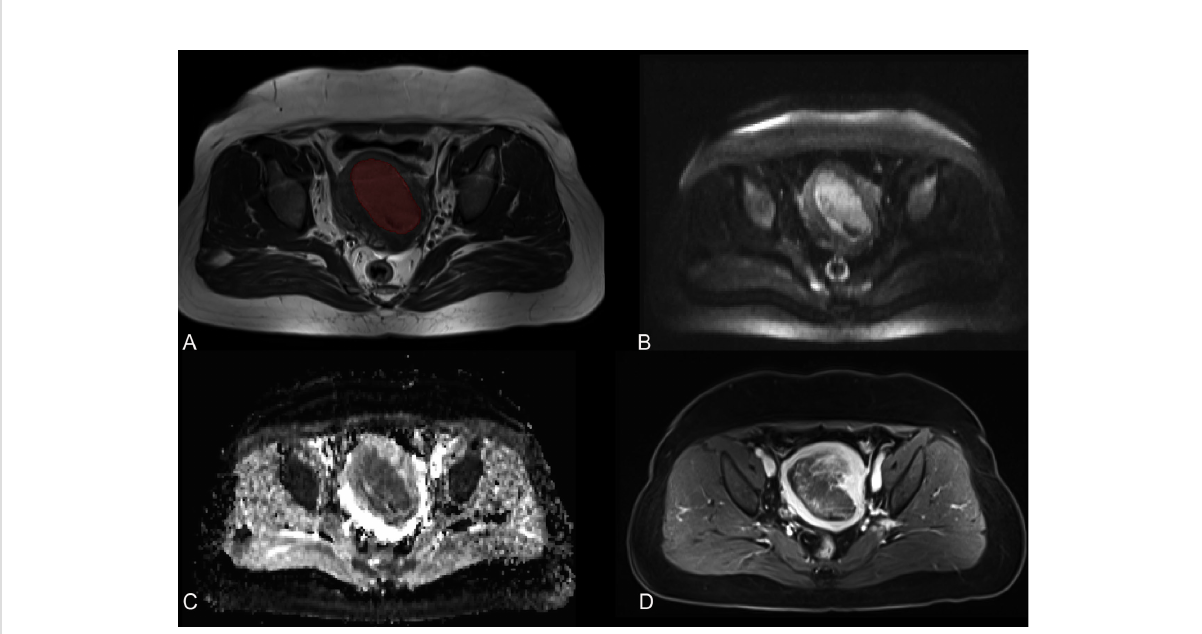
FIGURE 2 MR images of a 78-year-old woman with endometrial cancer. (A) Axial T2-weighted imaging is marked with a region of interest. (B) Axial diffusion-weighted imaging (b = 800 s/mm 2 ). (C) Axial apparent diffusion coef fi cient imaging. (D) Axial contrast-enhanced T1-weighted